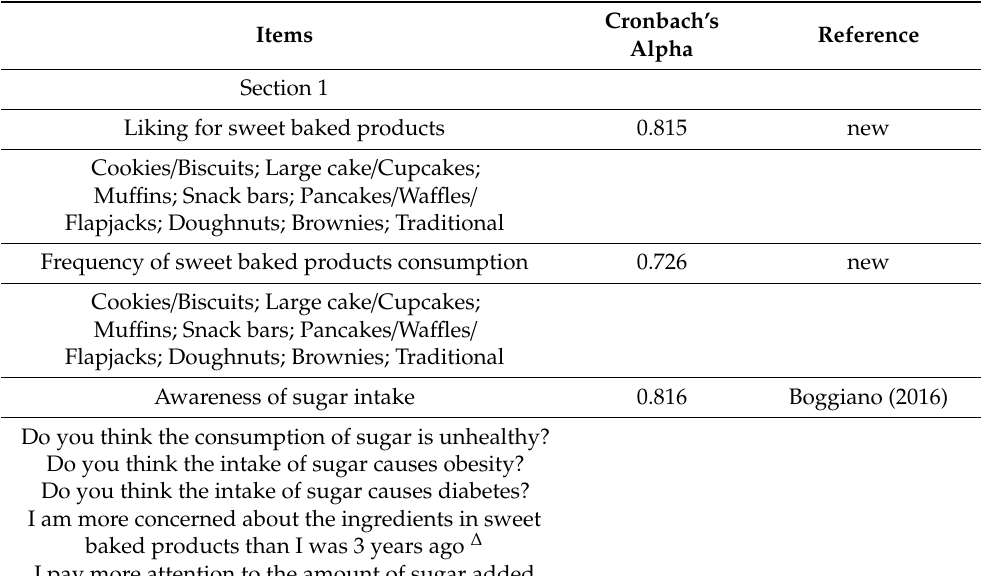
Table 1. Items used for cluster analysis, including internal consistency